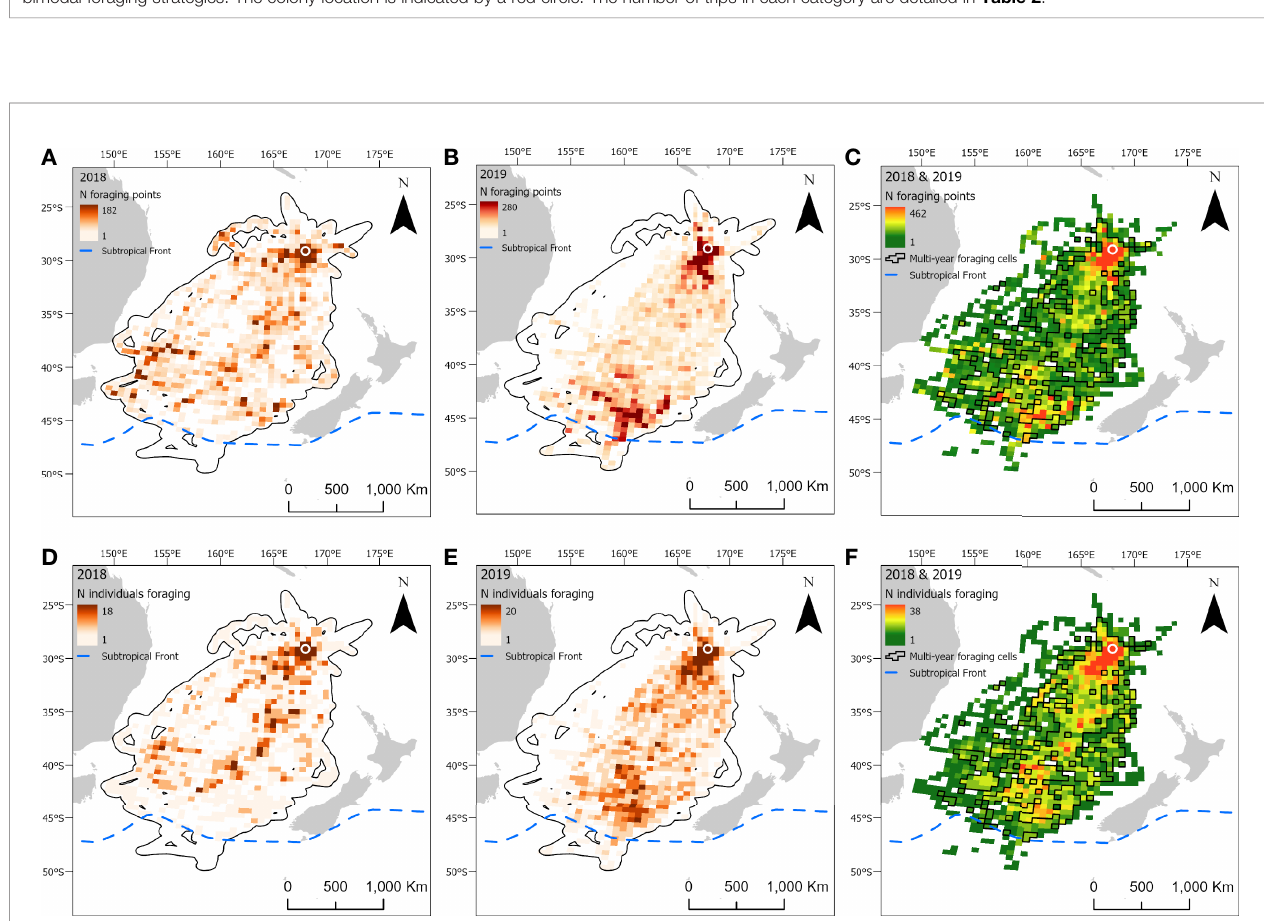
FIGURE 4 | At-sea distribution and locations of foraging behavior in chick-provisioning black-winged petrels ( Pterodroma nigripennis ). Grid cells (50 x 50 km) depict the number of foraging locations in 2018 ( A ; n = 24 individuals) and 2019 ( B ; n = 24 individuals) and combined number of foraging locations in 2018 and 2019 (C) . Number of individuals foraging in each grid cell in 2018 (D) and 2019 (E) ; and the combined number of individuals foraging in each grid cell in both 2018 and 2019 (F) . Polygonised cells in C and F represent grid cells in which birds foraged in both years. The location of the breeding colony is represented by a white circle. Black polygons around the foraging areas (A, B, D, E) represent the home range (99% utilization distribution). The approximate location of the Subtropical Front is represented by a dashed blue